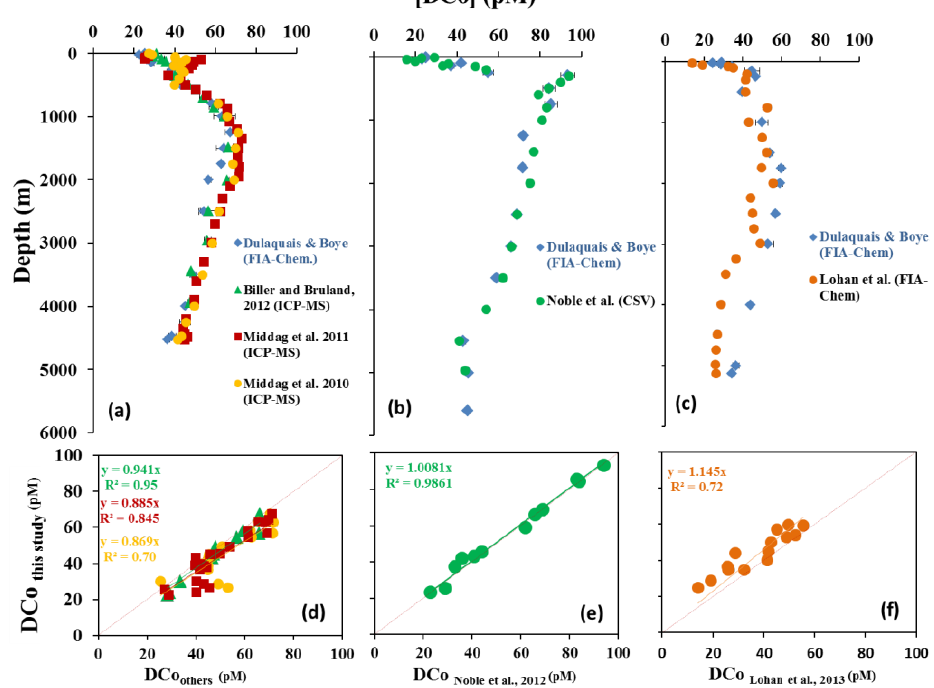
Fig. 6. Intercomparison of D Co data sets at the crossover station BATS (a, d) between this study (blue diamonds) and ICP-MS method by Biller and Bruland (2008) (green triangles) and by R. Middag et al. (personal communication, 2014) (yellow dots = samples from the 2010 Dutch GEOTRACES-A02 cruise; red squares = samples from the 2011 American GEOTRACES-A03 cruise); at the crossover station located at 9 ◦ S (b, e) between this study (blue diamonds) and the CSV method by Noble et al. (2012) (green dots); and at the crossover station at 40 ◦ S (c, f) between this study (blue diamonds) with FIA-chemiluminescence method by M. C. Lohan et al. (personal communication, 2014) (orange dots = samples from the 2010 English GEOTRACES-A10